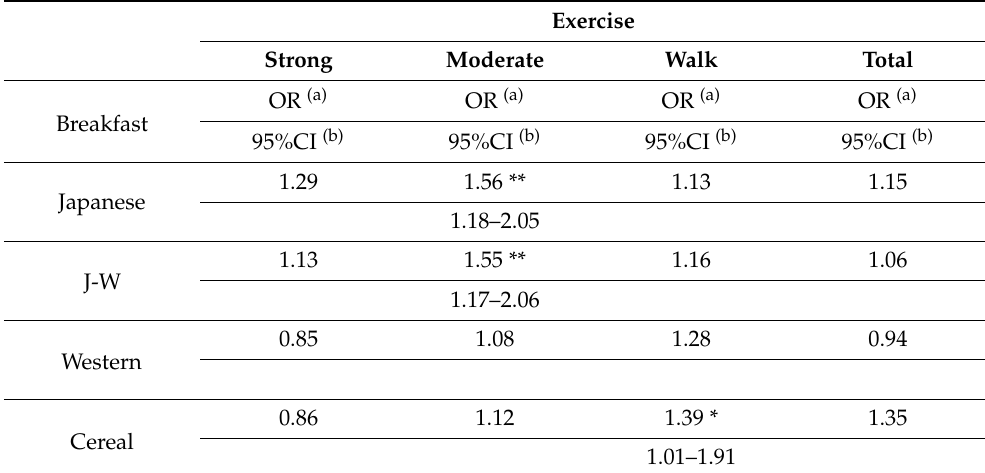
Table 4. Binomial logistic regression analysis for the interaction between various exercise factors and breakfast